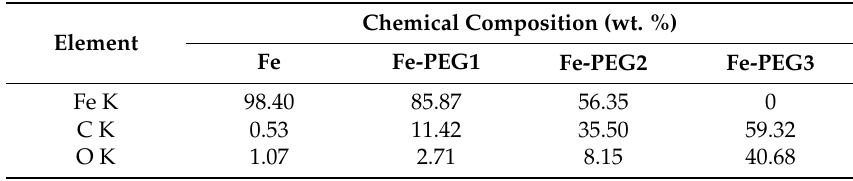
Table 2. Chemical composition of the surface of sintered iron samples, uncoated and coated with different amounts of the PEG layer.